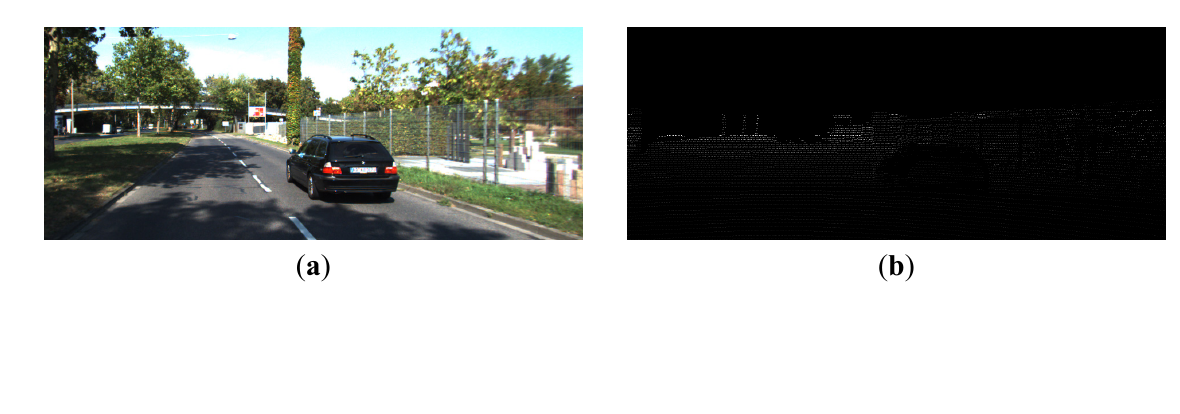
Figure 6. ( a ) Visual image; ( b ) Sparse range data in image frame; ( c ) Recovered depth image; ( d ) Confidence scores of the dense depth